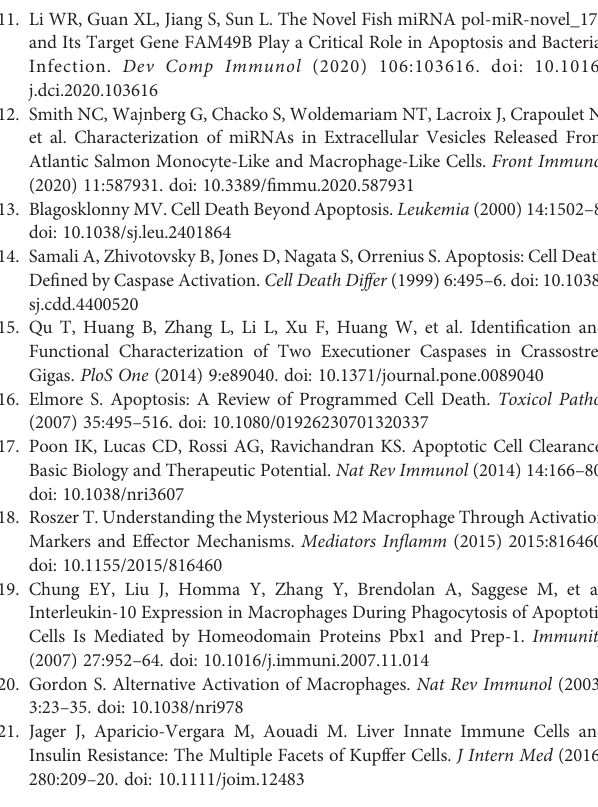
Supplementary Figure 1 | Kupffer cells (arrows) were isolated from healthy grass carp